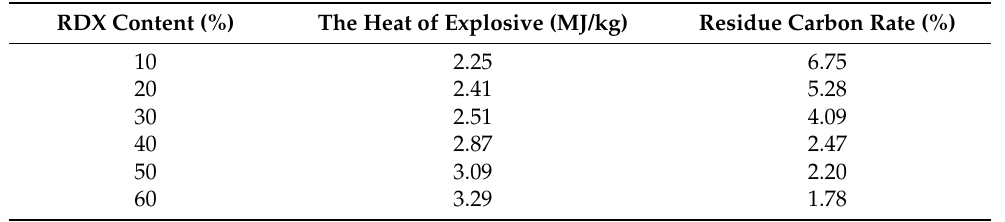
Table 4. The heat of explosive and residue carbon rate of energetic polymer composites with di ff er-